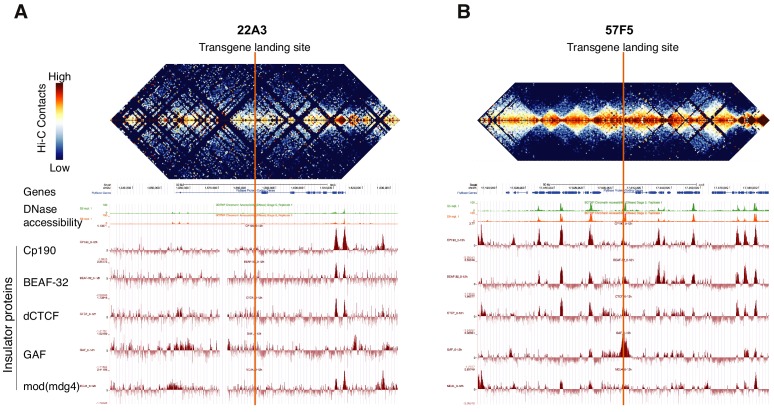
Chromatin landscape of genomic loci 22A3 and 57F5 determined from Hi-C data.(A, B) Heat maps of aggregate Hi-C data used to calculate chromosomal contact frequency for the embryonic nc14 genome. Vertical orange lines denote the precise locations of the two transgenic landing sites at 22A3 (A) and 57F5 (B). Below the heat maps are shown tracks for annotated genes, DNase accessibility, and ChIP-seq of the insulator proteins CP190, BEAF-32, dCTCF, GAF and mod(mdg4). The plots are adapted from Stadler et al. (2017), Liu et al. (2008) and Nègre et al. (2010). Although these data were derived from embryonic genomes, Stadler et al. (2017) showed that the embryonic TAD boundaries correspond to the locations of interband regions of larval polytene chromosomes. This strongly suggests that TAD organization is largely maintained during the development of embryos into third-instar larvae.